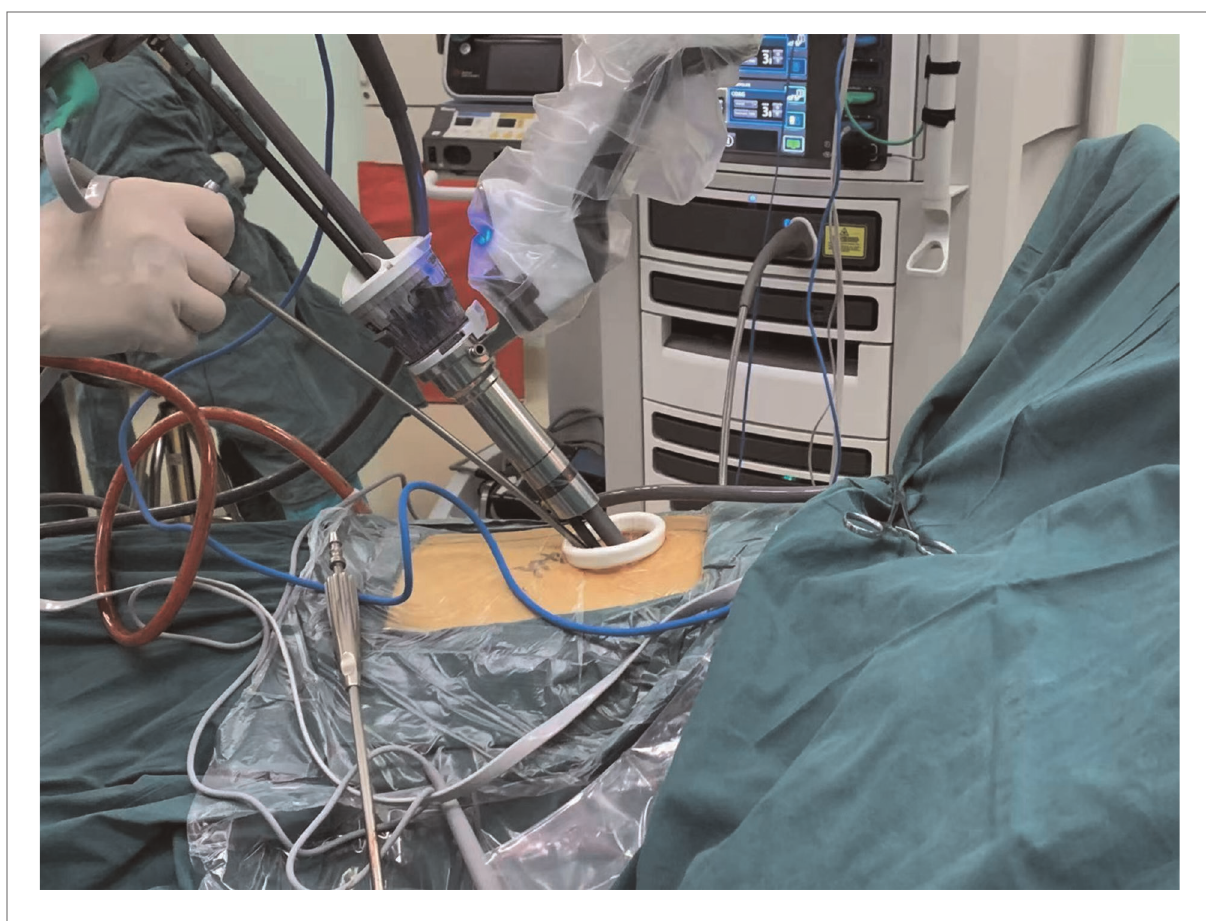
FIGURE 5 Placement of the instruments and suction apparatus used by bedside